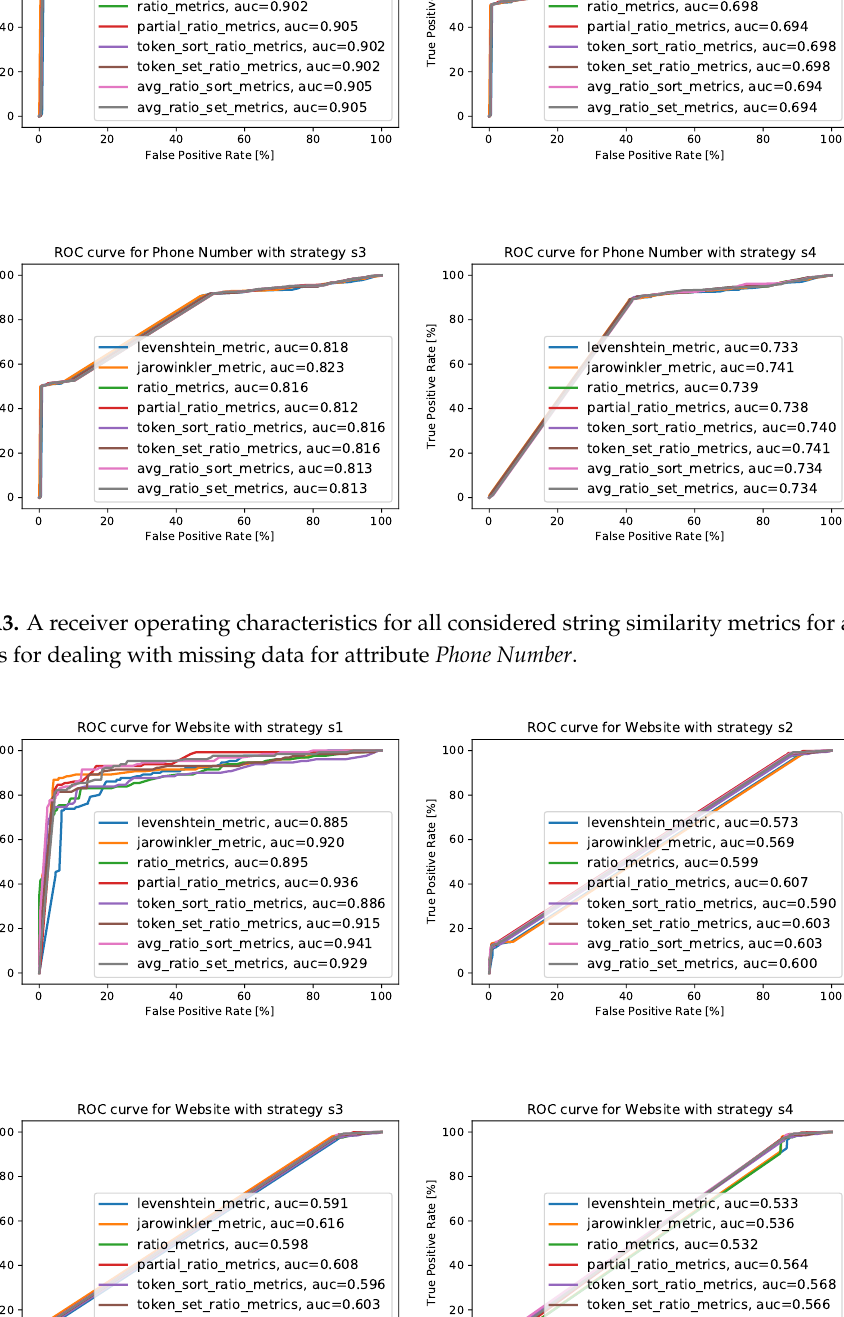
ROC curve for Phone Number with strategy s2